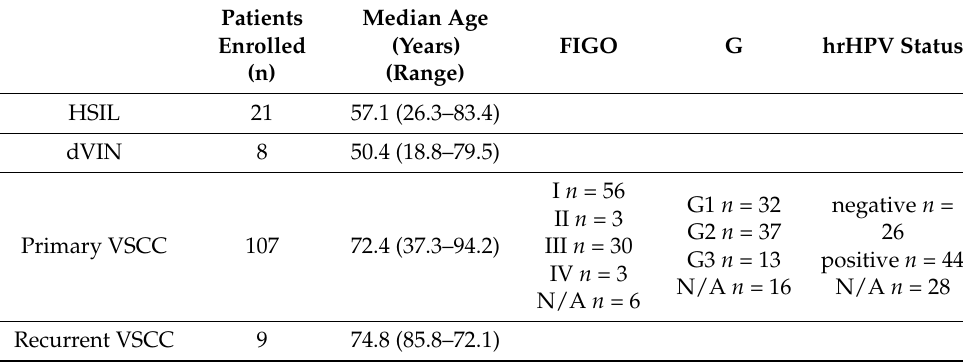
Table 1. Basic demographic data of enrolled patients 1